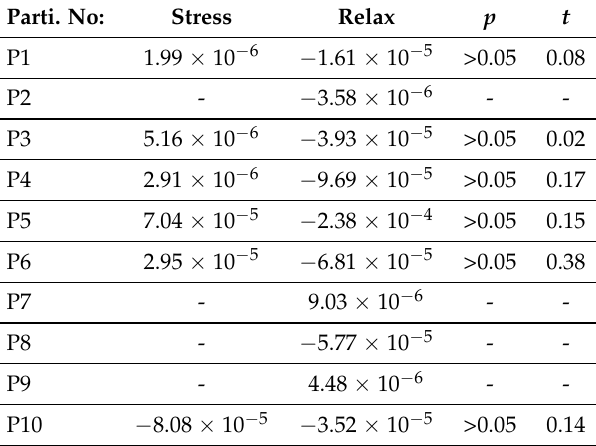
Table 5. Summary of EDA slopes of each participants while being stressed and relaxed. Parti.